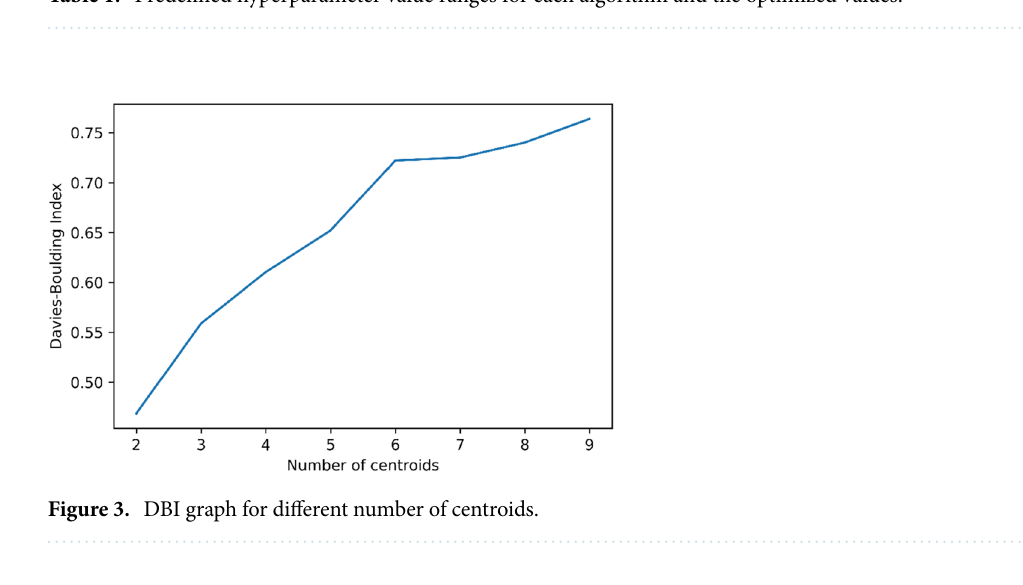
Table 1. Predefined hyperparameter value ranges for each algorithm and the optimized values.